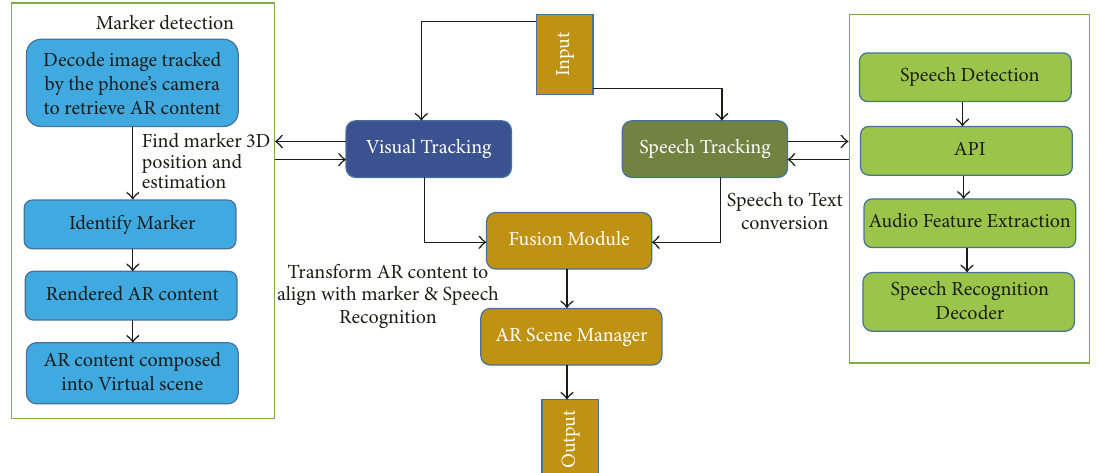
Figure 4: System architecture (adapted from [34, 35]).